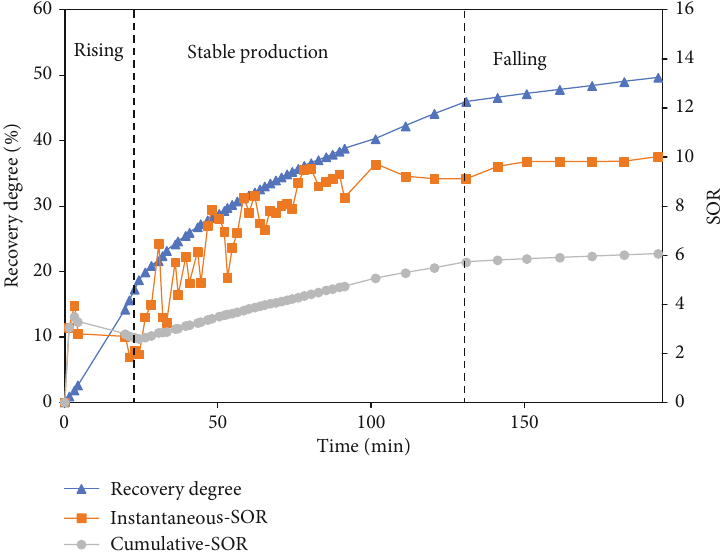
Figure 16: The recovery degree and SOR of 300 ° C superheated